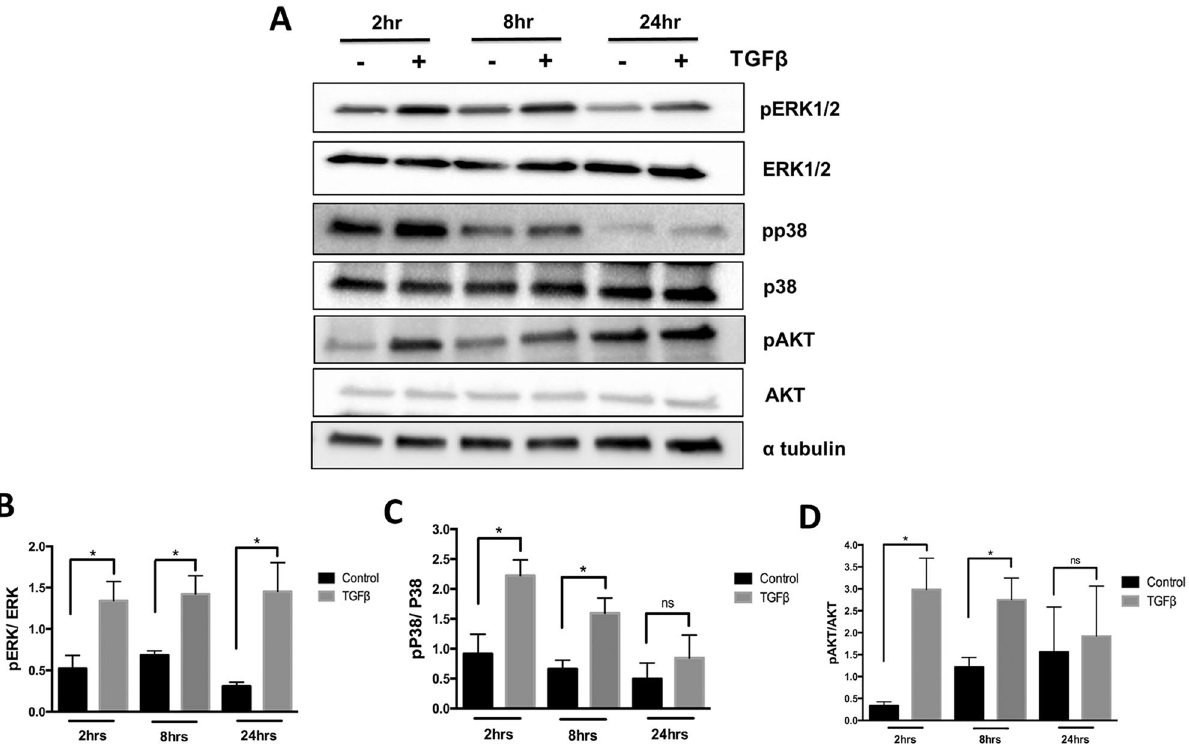
Figure 3. TGF-β signaling regulates noncanonical pathways in the sclerotome. Sclerotome was treated with vehicle control or TGFβ1 for 2, 8 or 24 h. Immunoblot was used to determine activity of ERK, p38 and AKT. ( B ) ERK, ( C ) P38 and ( D ) AKT activity was quantified as the relative levels of the phosphoprotein over the total protein as determined from ImageJ scanned blots. α tubulin was used as a general loading control. (*) indicates significance, p < 0.05, n = 3. Immunoblots were cropped for clarity. Examples of uncropped blots are found in Supplementary